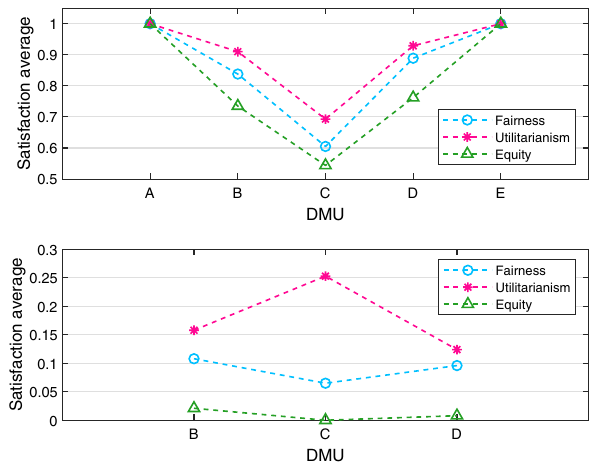
Fig. 3 Trends in mean and SD of satisfaction under different ethical